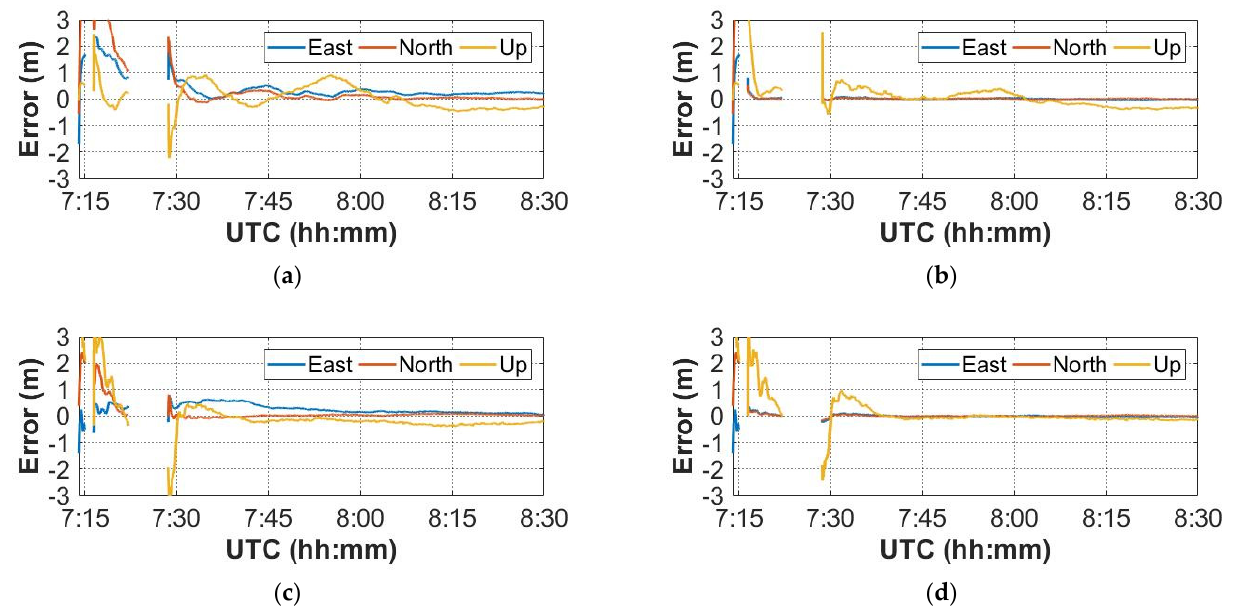
Figure 12. The positioning errors of GNSS-only and GNSS/UWB solutions during GNSS outage. ( a ) GPS PPP; ( b ) GPS/UWB; ( c ) GPS + GLONASS PPP; ( d ) GPS + GLONASS/UWB.